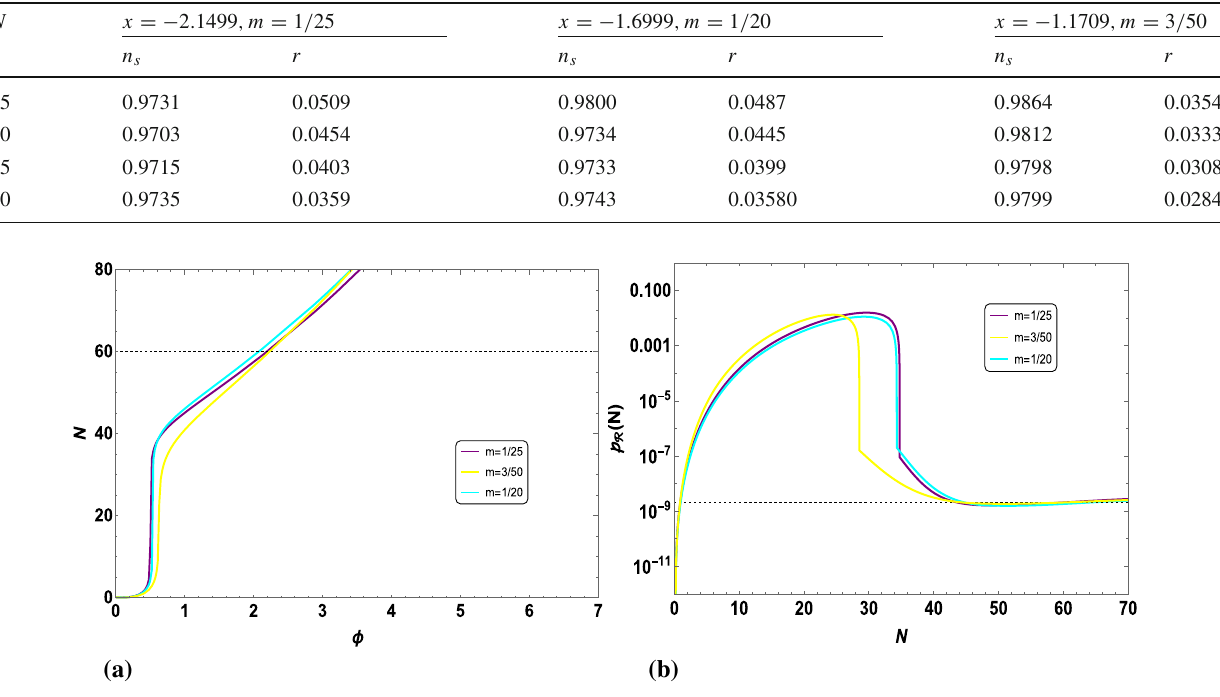
Fig. 3 Left panel: three different colors correspond to three differ- ent values of potential parameter x . Purple color corresponds to x = − 2 . 1499, yellow is for x = − 1 . 1709 and cyan stands for x = − 1 . 6999. The number of e-folds ( N ) as a function of the scalar field ( φ ). The dot- tedblacklinecorrespondstothe N = 60. Rightpanel: thescalarpower spectrum as a function of the Number of e-folds ( N ). Three different colorscorrespondtothreedifferentvaluesofpotentialparameter x .Pur-